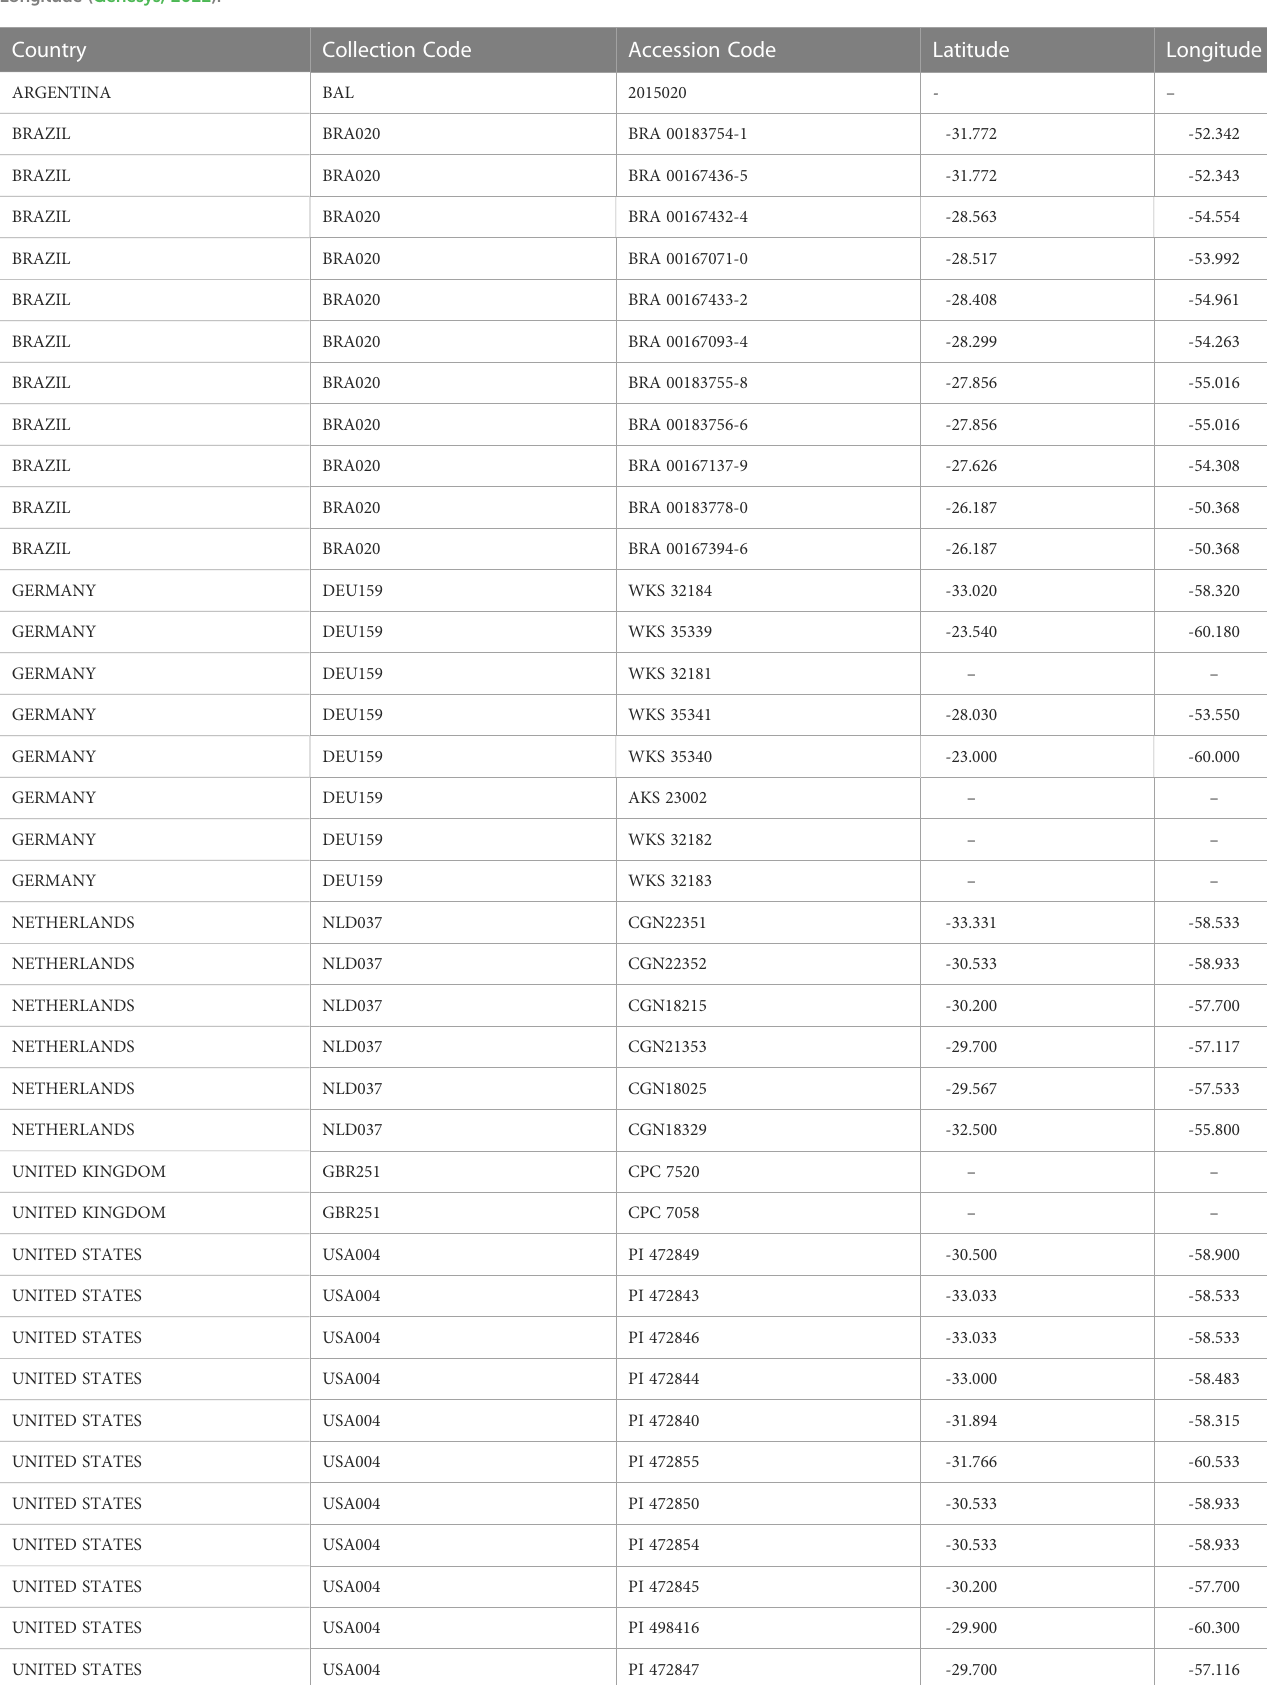
TABLE 2 Summary of Solanum malmeanum (Solanaceae) accessions at genebanks following Country, Collection Code, Accession Code, Latitude and Longitude (Genesys,